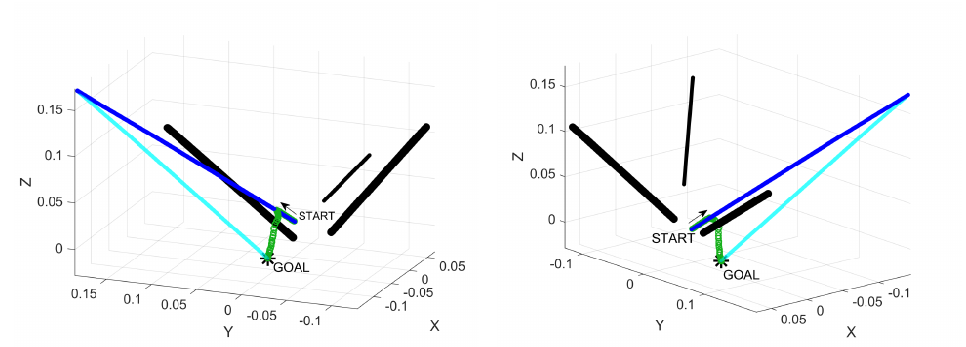
Figure 13. In blue, the starting pose of the robot, while in light-blue, the goal pose. In black, the other laparoscopic tools that are to be considered as obstacles. In green, the trajectory of the EE.